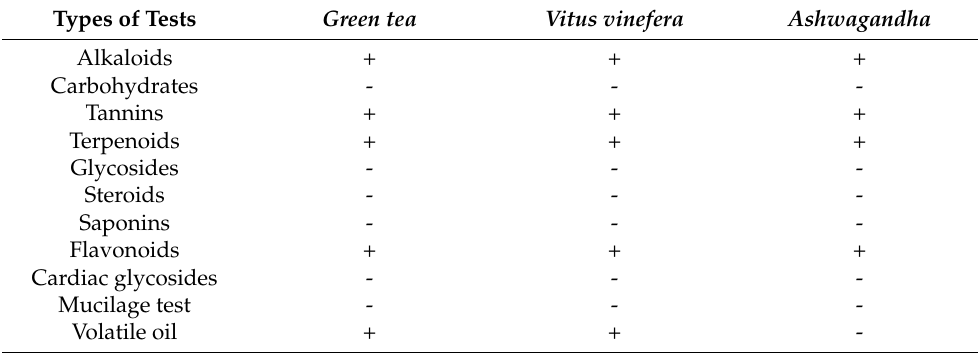
Table 2. Phytochemical screening of three plant extracts for bioactive